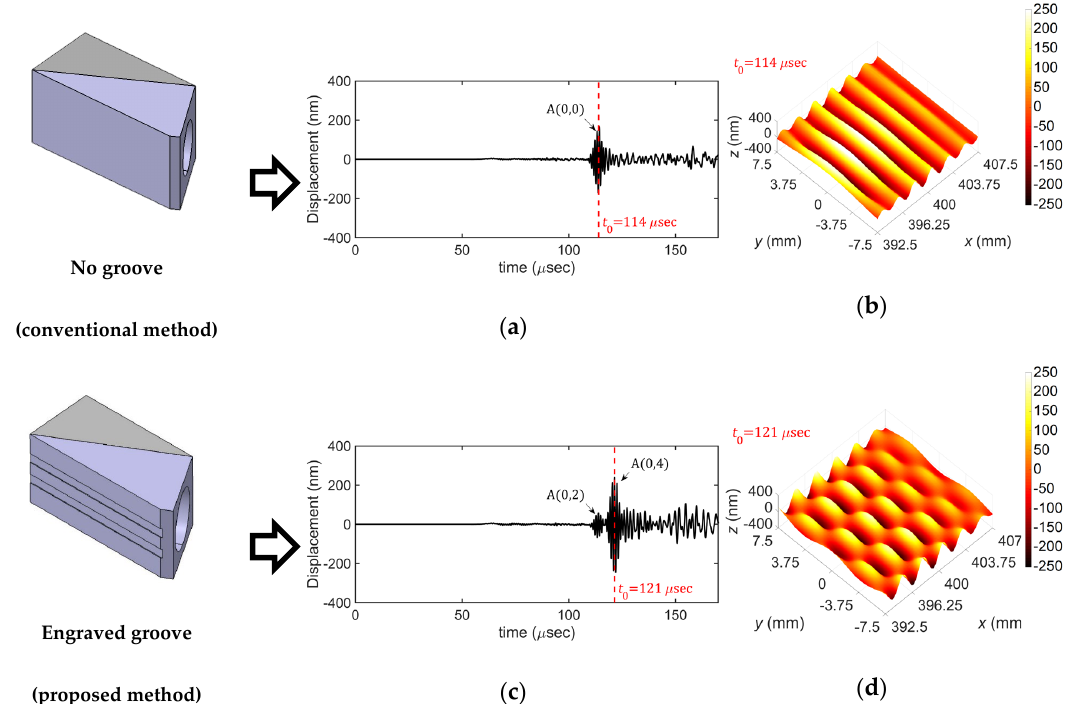
Figure 9. (a) Meshed FEM model and (b) overview of the entire FEM model and propagation snapshot of the excited A(0,4) mode.